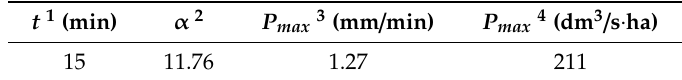
Table 5. Design rainfall volume for p = 20%.